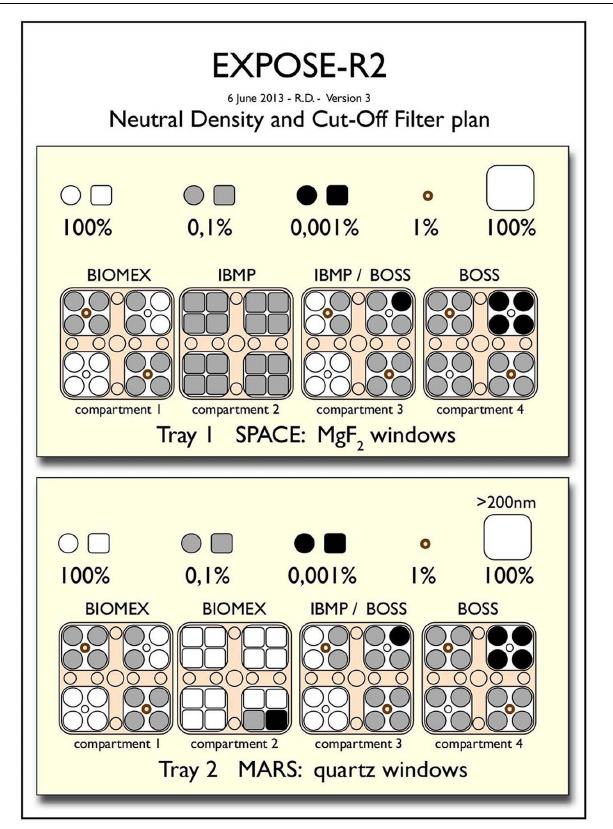
FIGURE 5 | Experiments as accommodated for flight in EXPOSE-R2. Credit: René Demets, ESA.